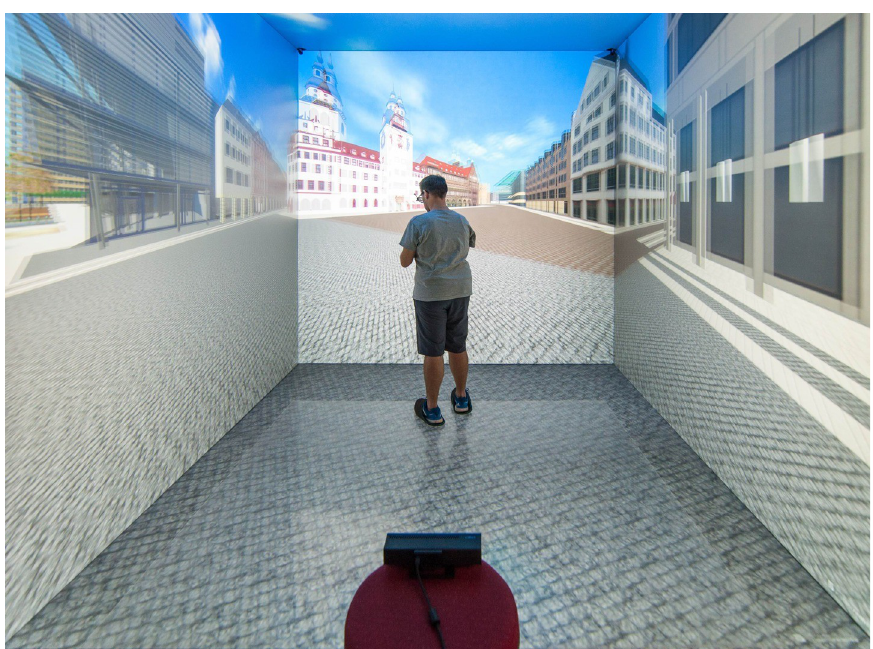
Fig 2. The virtual reality study setup showing the experimental setup in the virtual city center of Chemnitz, Germany inside the five-sided cave automatic virtual environment.